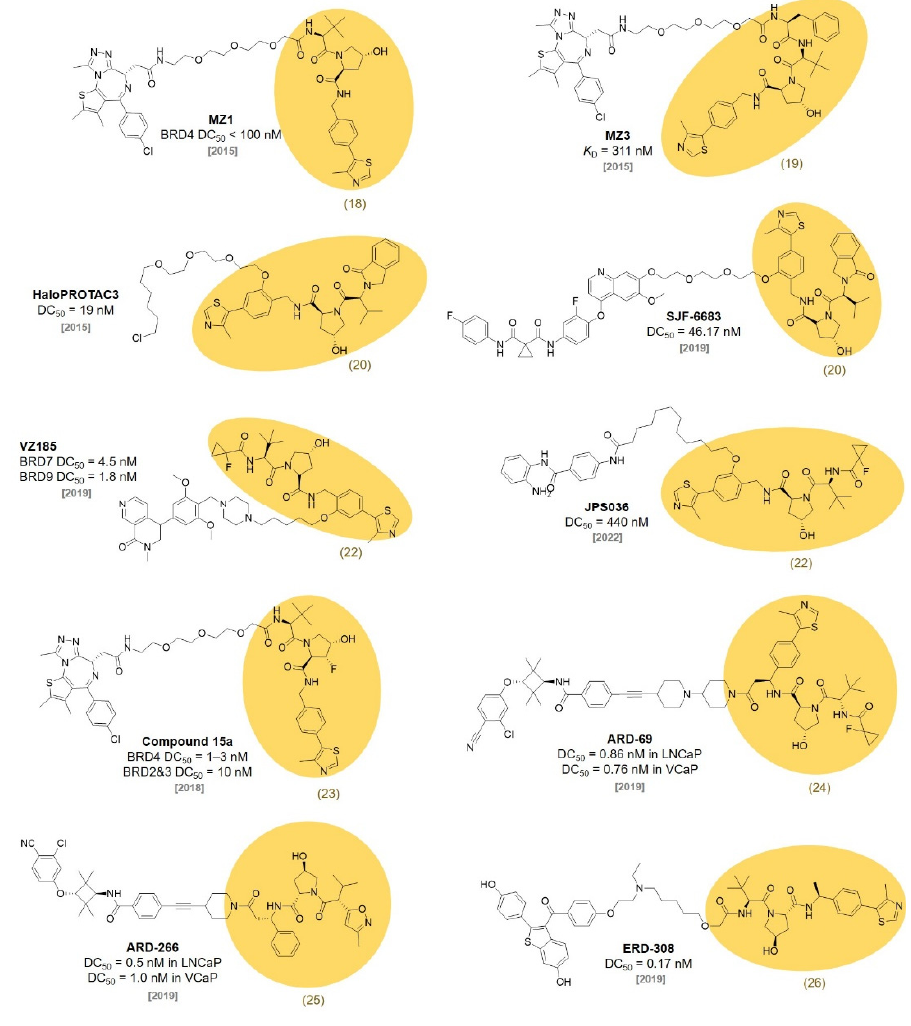
Figure 6. Reported PROTACs based on the VHL ligands.